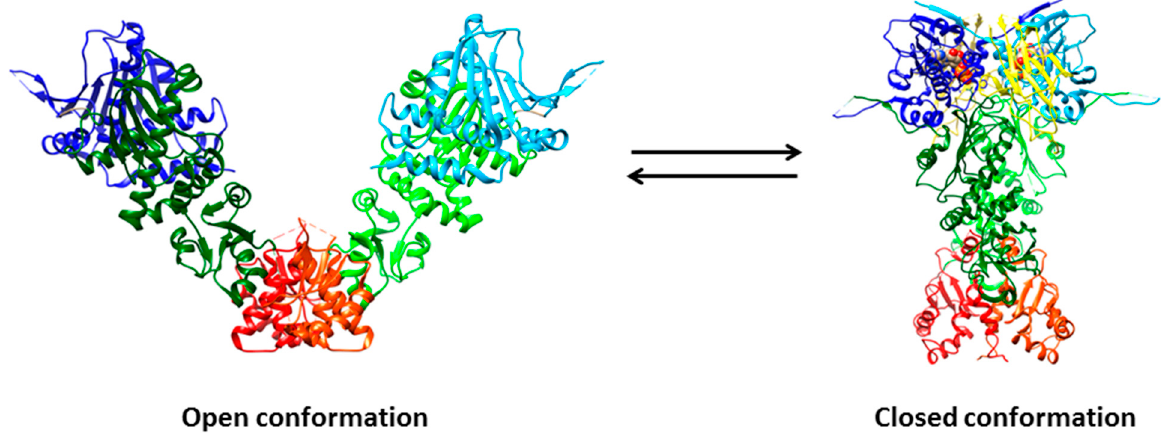
Figure 1. Crystal structures of open ( i.e. , ligand-free) full-length Hsp90 from E. coli (HtpG; PDB ID: 2IOQ) and closed ( i.e. , ATP- and p23-bound) yeast Hsp90 (PDB ID: 2CG9). The N - domain is depicted in blue and cyan, the middle domain in dark green and light green, and the C -domain in red and orange. The p23 co-chaperone is in yellow, whereas ATP is depicted through a space-filling representation. Pictures were drawn by UCSF-Chimera